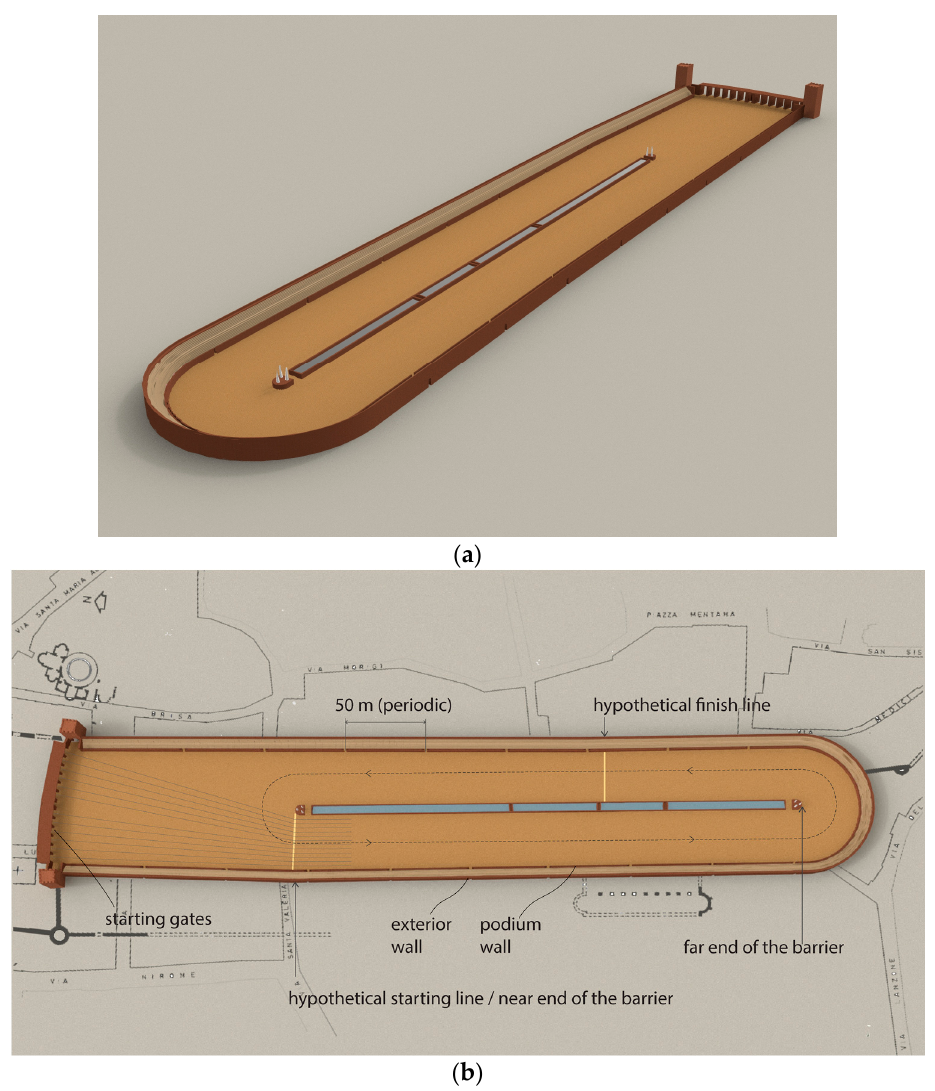
Figure 12. The reconstruction of the circus: ( a ) prospective view; ( b ) a plan view overlapped to the city map from which it is possible to see the change of direction of the exterior walls in correspondence with the starting line, a technical expedient to permit all the chariots to run the same length before arriving at the starting line.